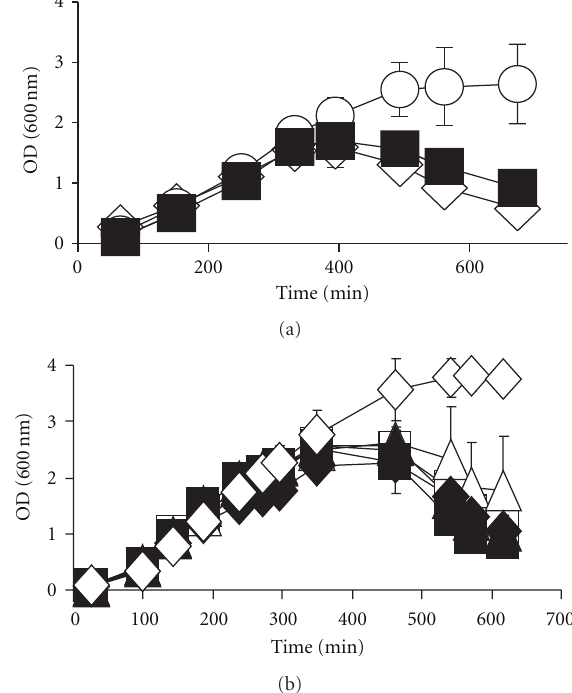
Figure 3: E ff ect of nonglycolytic carbon sources and sugar meta- bolism on viability. (a) Growth curves of ompR malT con mutants (strain AJW3098) grown in LB at 37 ◦ C without additional carbon source (white diamonds) or supplemented with serine (white circles) or succinate (black squares). Values represent the mean of triplicates. Error bars are only shown when greater than the symbol. (b) Growth curves of ompR malT con , (strain AJW3098, diamonds), ompR malT con srlA (strain AJW3926, squares) and ompR malT con srlD (strain AJW3927, triangles) mutants grown in LB at 37 ◦ C. Black symbols, cells grown in LB without sorbitol; white symbols, cells grown in LB supplemented with 22mM sorbitol. Values represent the mean of triplicates. Error bars are only shown when greater than the